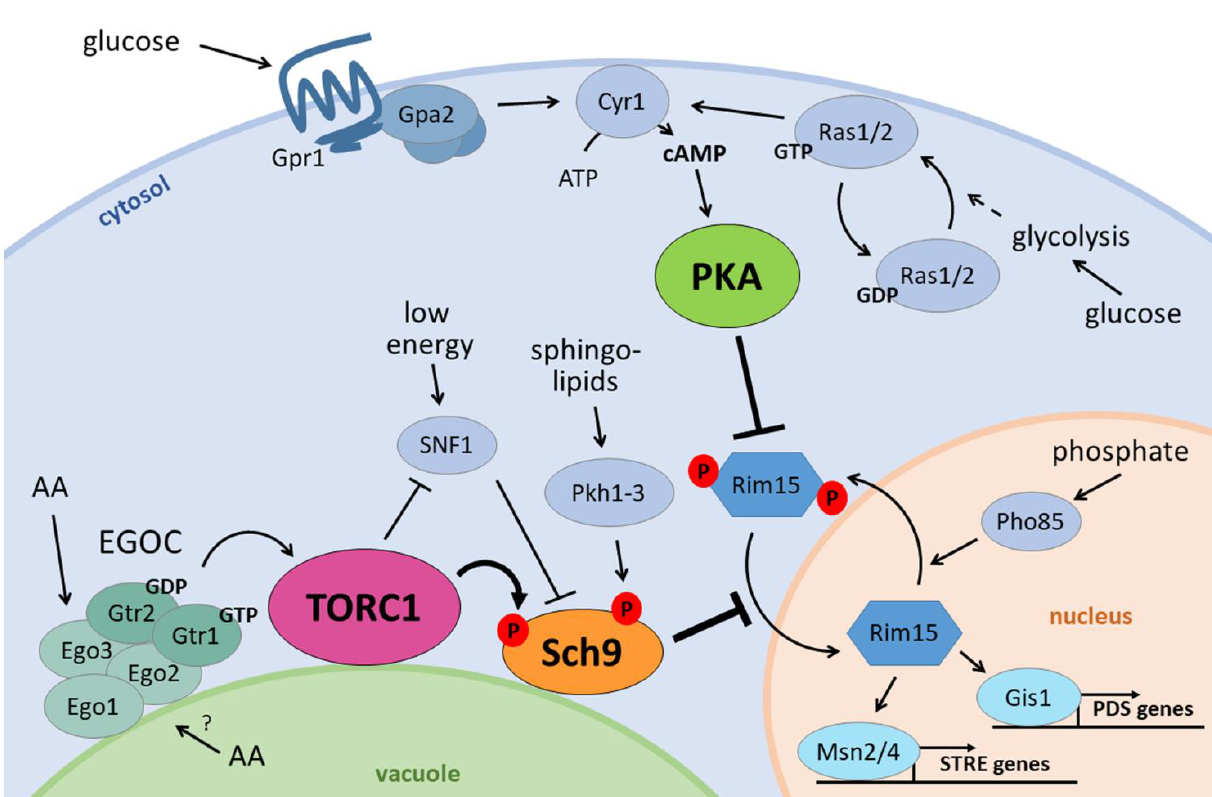
FIGURE 1: The nutrient signalling ménage-à-trois. Glucose stimulates PKA activity through the GPCR system of Gpr1 and Gpa2 on the one hand, and through activation of Ras1/2 on the other. Both induce cAMP production by Cyr1, activating PKA. At the vacuolar membrane, the EGOC senses amino acids from the cytosol and presumably the vacuole, and activates TORC1 in return. TORC1 negatively regulates the en- ergy sensor SNF1 and activates Sch9 through phosphorylation. Besides TORC1, also SNF1 influences Sch9 activity as well as the sphingolipid effectors Pkh1-3. The PKA and TORC1/Sch9 branches converge on multiple players, perhaps the most prominent being Rim15, whose import into the nucleus is inhibited by both branches and is also controlled by phosphate availability through Pho85. When the ménage-à-trois is inactive, Rim15 can enter the nucleus where it induces transcription of PDS genes by Gis1 and STRE genes by the Msn2/4 transcription fac-